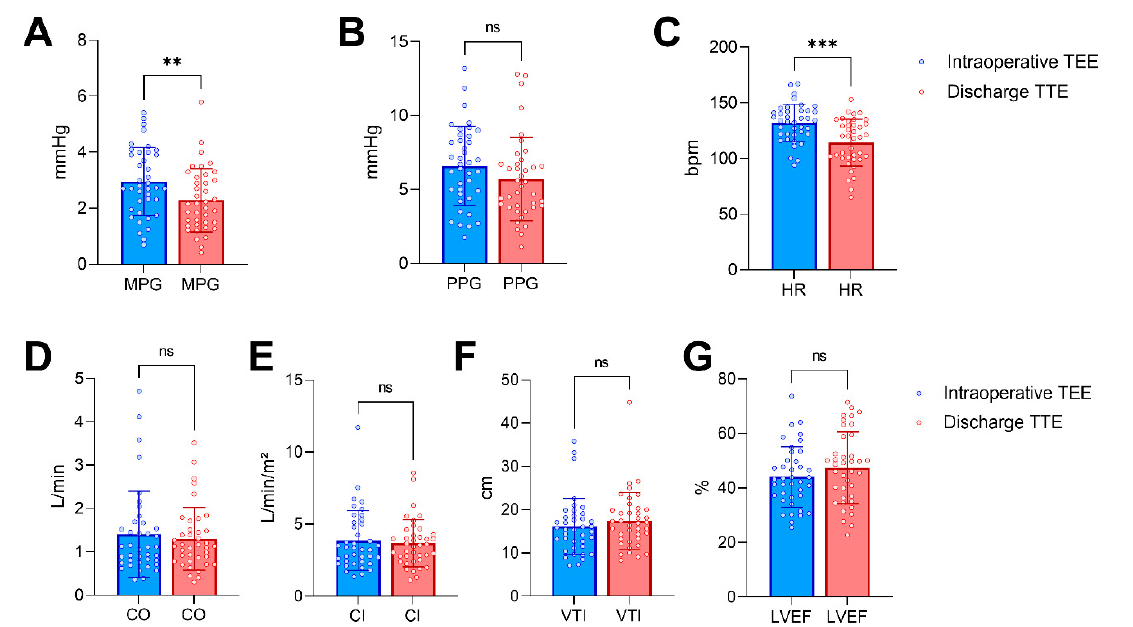
Figure 2. Intraoperative and pre-discharge echocardiographic and hemodynamic variables. Comparison of the left atrioventricular valve (LAVV) mean pressure gradient (MPG, A ), LAVV peak pressure gradient (PPG, B ), heart rate (HR, C ), cardiac output (CO, D ), cardiac index (CI, E ), LAVV velocity-time integral (VTI, F ) and left ventricular ejection fraction (LVEF, G ) derived from the intraoperative transesophageal echocardiography (TEE, blue color) and awake transthoracic echocardiography (TTE, red color) prior to discharge. Bars and antennas represent means and standard deviations, respectively. Comparisons were performed with the paired Student’s tests or the Wilcoxon matched-pairs signed rank tests. ** = p < 0.01, *** = p < 0.001, ns = not significant.